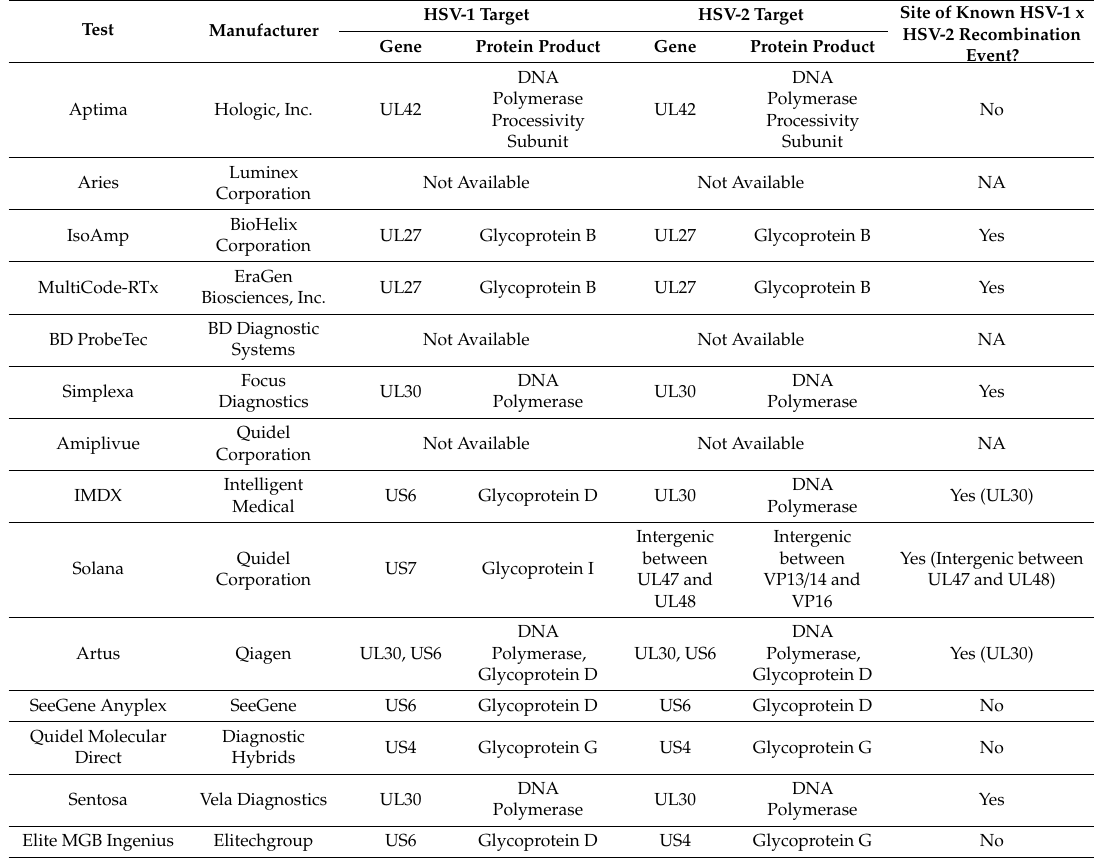
Table 1. Genes targeted by commercial HSV typing